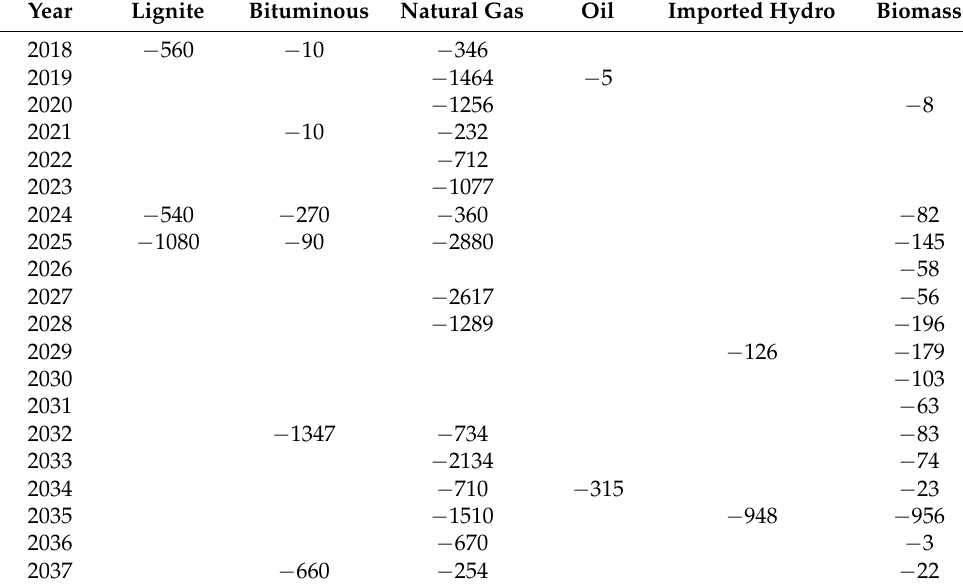
Table A6. Retired conventional generation units (MW).